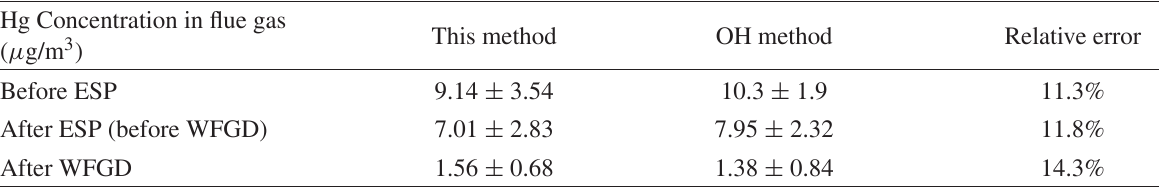
TABLE 9: Comparison of Hg measurements in flue gas between the new sorbent method and OH method in plant-3 ( n = 3